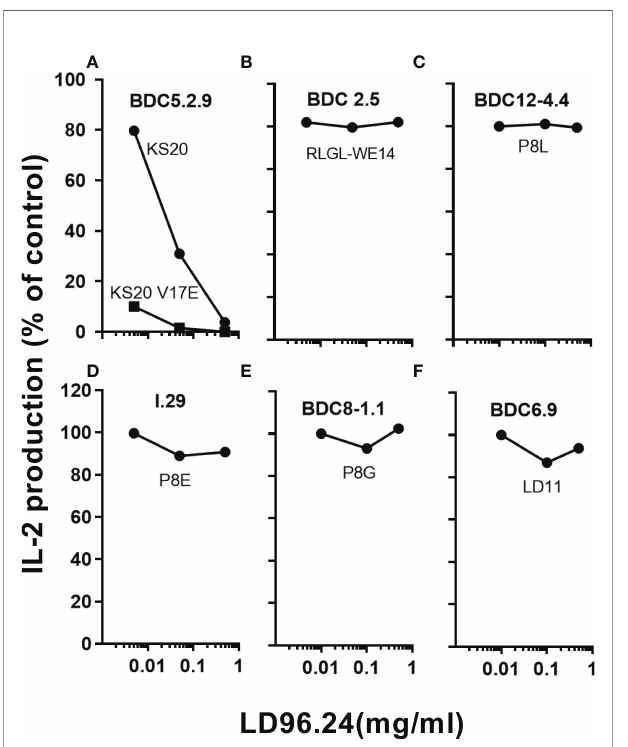
FIGURE 2 | LD96.24 speci fi cally inhibits the KS20-speci fi c T-cell responses. The inhibition of LD96.24 on different autoantigen-reactive T cells were assessed in vitro . As shown in the methods, different T cells including BDC5.2.9 speci fi c for KS20 (A) , BDC2.5 speci fi c for ChgA (RLGL-WE14 peptide) (B) , BDC12-4.4 speci fi c for Ins P8L (C) , I.29 speci fi c for Ins P8E (D) , BDC8-1.1 speci fi c for Ins P8G (E) , and BDC6.9 speci fi c for LD11 (F) were incubated with APCs loaded with different peptides and different concentrations of LD96.24 for 24 h at 37°C, and IL-2 production was tested with the HT-2 assay. The results are shown as the percentage of the response remaining compared with the no LD96.24 control.